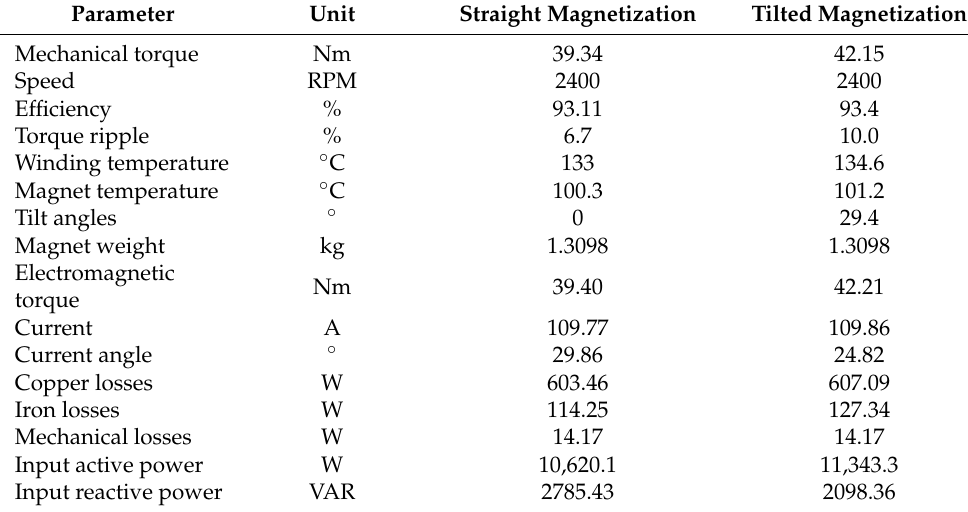
Table 6. Performance comparison between straight and tilted magnetization for the baseline motor model of Figures 1 and